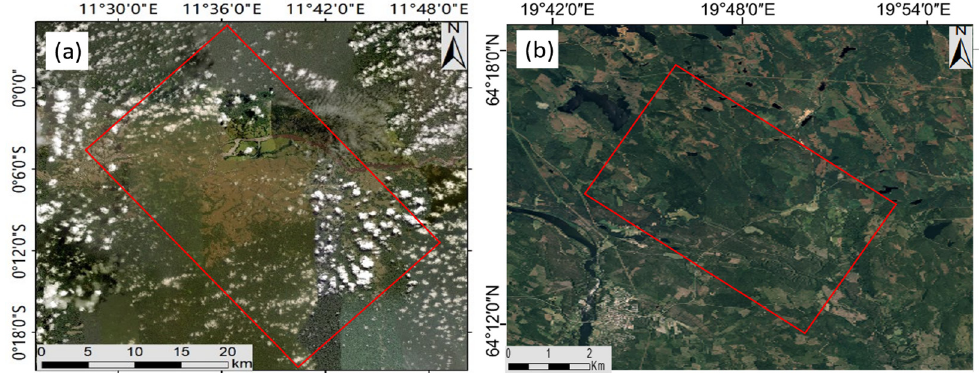
Figure 1. The optical image of the test site (copyright Google Earth) and the corresponding SAR data location (red box). ( a , b ) are the Lope and Krycklan test areas, respectively.